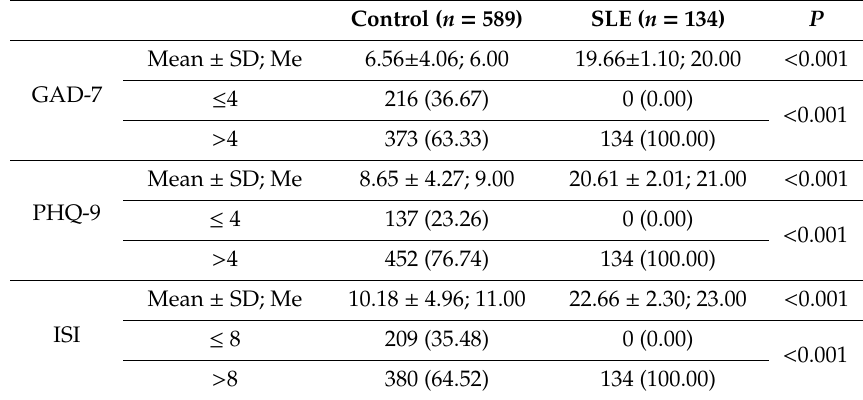
Table 2. Comparison of the severity of anxiety, depression, and sleep disorders in patients with and without systemic lupus erythematosus during the SARS-CoV-2 pandemic.